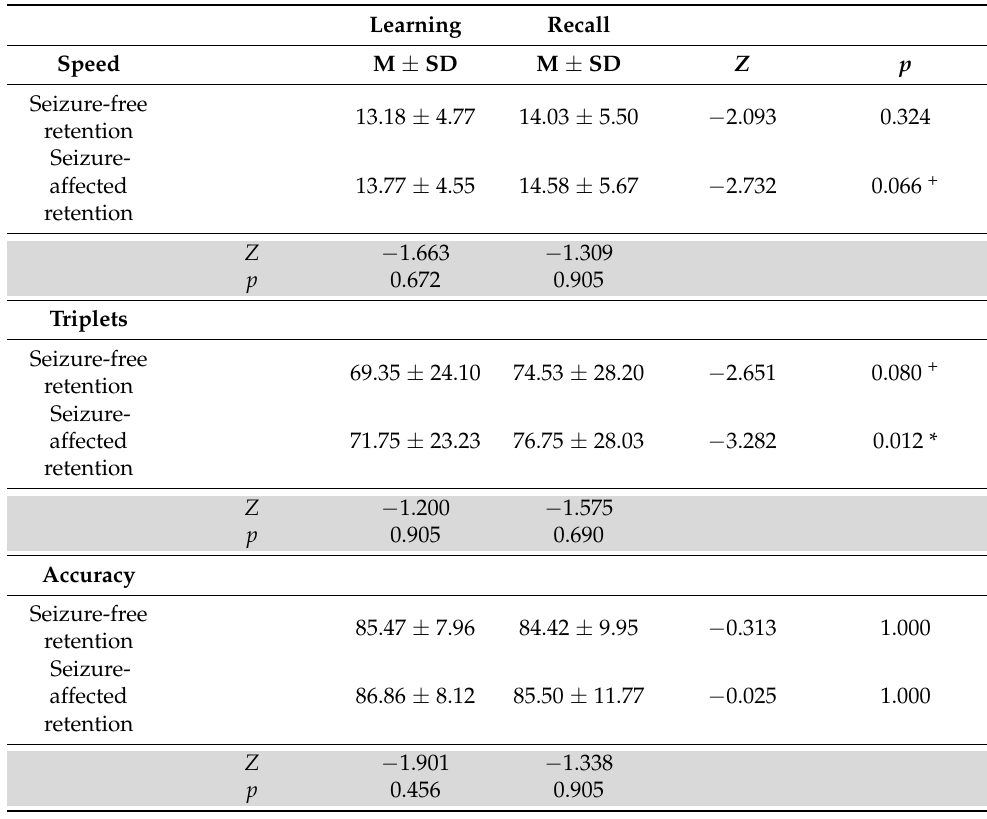
Table 3. Within-patient performance changes evaluated for retention periods that included Scheme 42. Learning Recall Speed M ± SD M ± SD Z